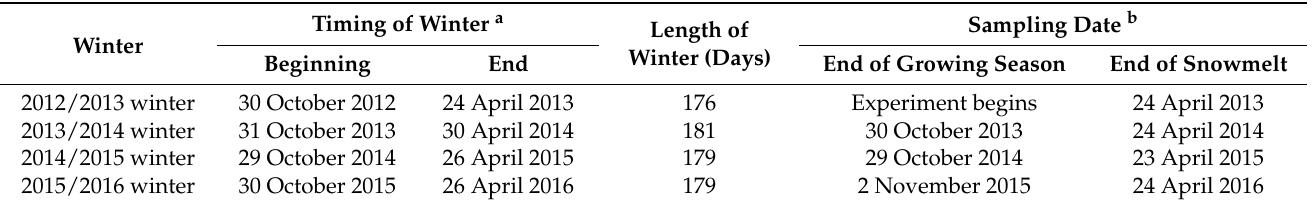
Table 2. Sampling comparison of the timing and length of winters during the four years of